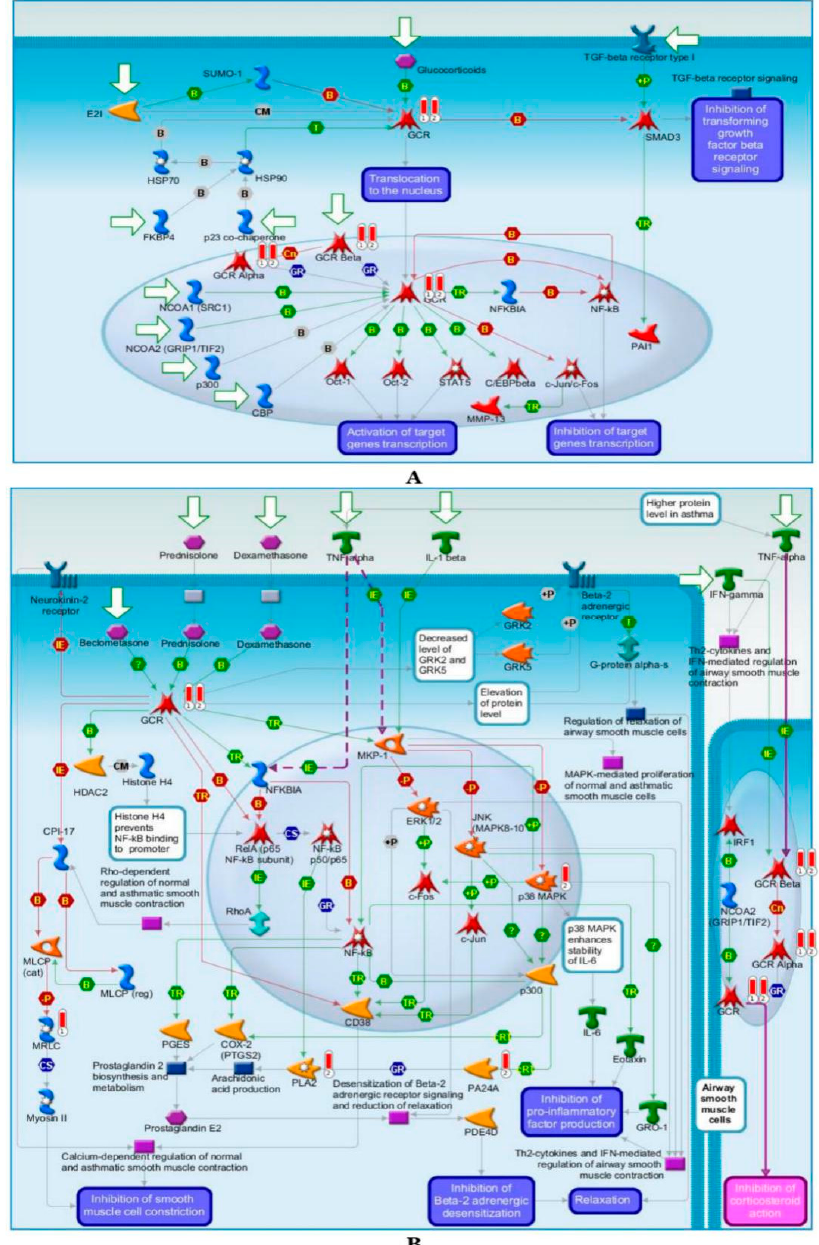
Figure 7. Enriched pathway maps. ( A ) Map of the Development Glucocorticoid receptor signaling. It is the top scored map (map with the lowest p -value) based on the enrichment distribution.